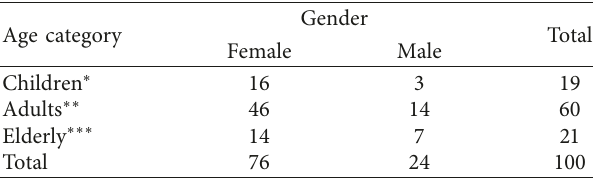
Table 3: Demographic data of study